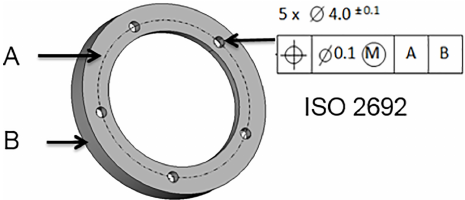
Figure 1. Nominal flange model and measured (extracted)